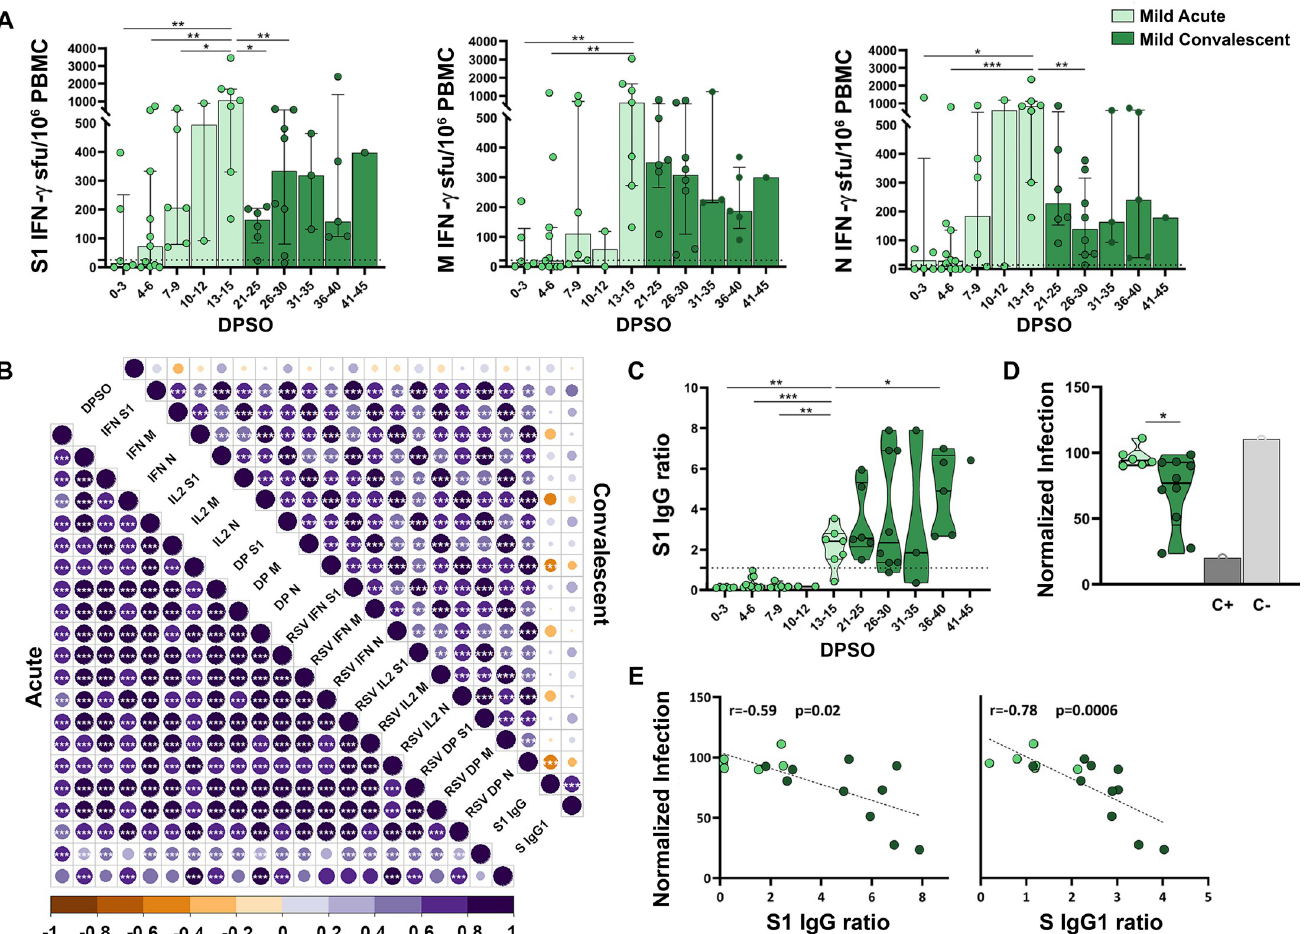
Fig 2. Cellular and humoral immune responses in mild natural infection, during acute and convalescent phases. ( A ) FluoroSpot IFN- γ responses against SARS-CoV-2 S1, M and N proteins according to the days post-symptom onset (DPSO). Data is represented as spot forming unit (sfu) per million PBMC. Dashed lines represent the positivity cut-off established by using a non-infected control group: > 25 sfu/10 6 PBMC for S1, > 21 sfu/10 6 PBMC for M and > 14 sfu/10 6 PBMC for N. ( B ) Correlation matrices of cellular and humoral immune variables analyzed. Only significant correlations (p < 0.05) are represented with asterisks. Positive correlations appear in purple, and negative correlations appear in orange. The size and the colour gradient of the circle corresponds to the magnitude of the correlation. ( C ) Results of SARS-CoV-2 S1 IgG ELISA according to DPSO. Dashed line represents the established cut-off of positivity (ratio � 1.1). ( D ) Neutralizing capacity of 1/500 diluted sera, tested with S protein-pseudotyped virus represented as percentage of normalized infection neutralized. ( E ) Correlation between neutralizing capacity and the semi-quantitative results of SARS-CoV-2 IgG ELISA (left) and anti-Spike IgG1 assessed by flow cytometry (right). Linear regressions were performed using Spearman’s rank test. Horizontal bars and whiskers represent median values and interquartile ranges, respectively. The significance between groups was determined using Mann Whitney or Wilcoxon signed rank tests, � p < 0.05, �� p < 0.01, ��� p < 0.001, ���� p < 0.0001. RSV: Relative Spot Volume; DP: IFN- γ / IL-2 double positive